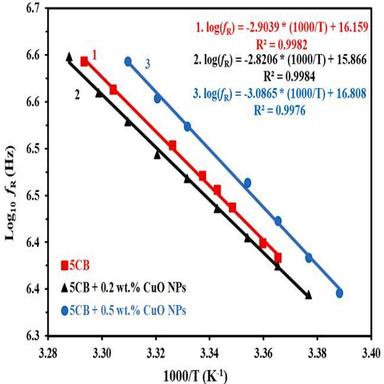
Variation of relaxation frequency (fR) with the inverse of absolute temperature (1000/T). Curves 1, 2, and 3 represents pure 5CB, 5CB + 0.2 wt% CuO NPs and 5CB + 0.5 wt% CuO NPs, respectively.